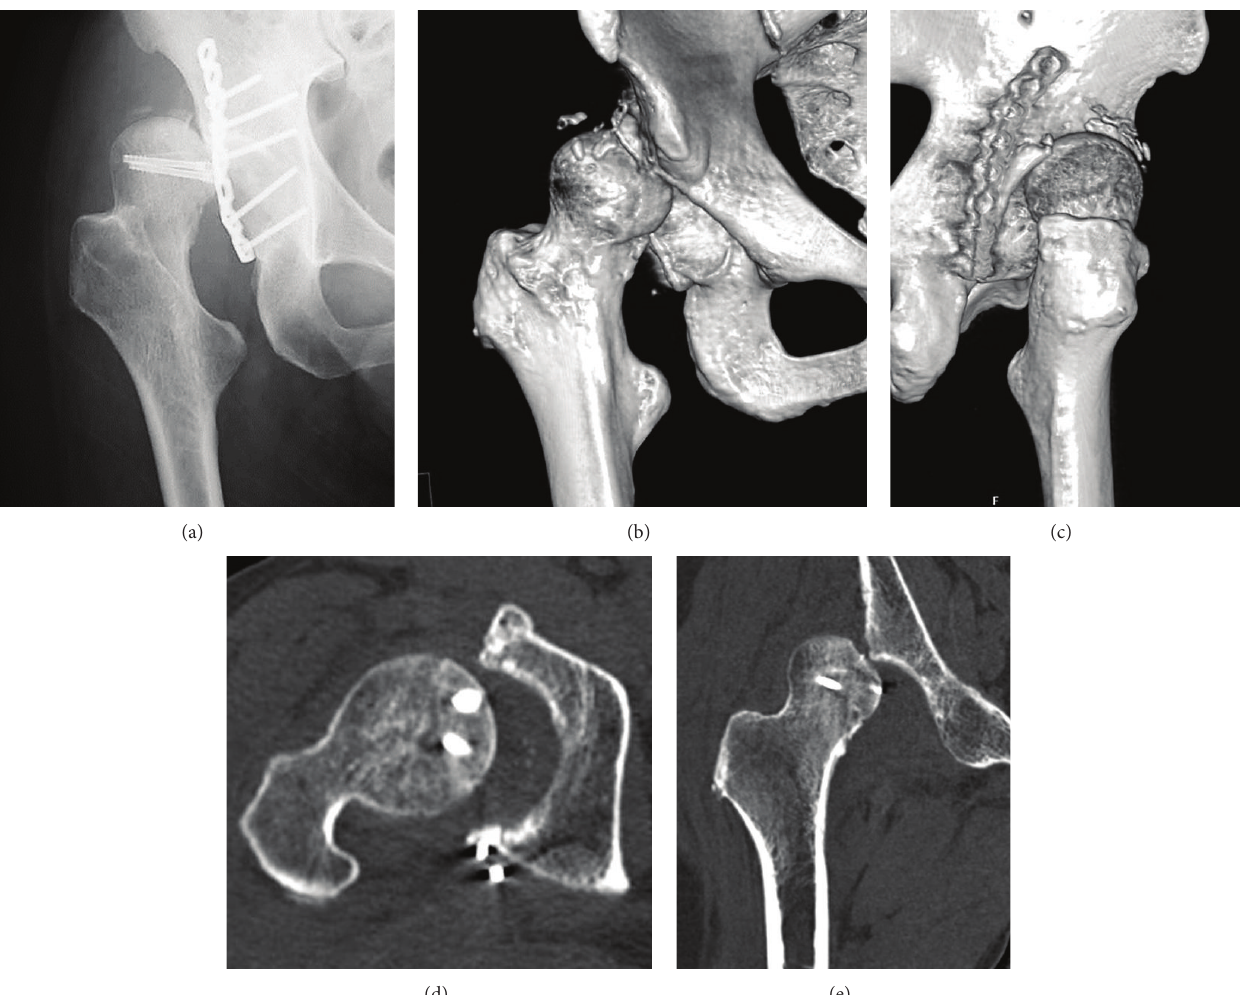
Figure 3: Case 1. (a) Anteroposterior X-ray image of the right hip at the superolateral dislocation. (b) Anteroposterior three-dimensional computed tomography showing superolateral dislocation of the femoral head and a bony defect of the superior part of the acetabular rim. (c) Posteroanterior three-dimensional computed tomography showing no displacement of the posterior fragments or implant failures. (d) Axial computed tomography showing irregular congruity, no displacement of the femoral head or posterior wall. (e) Coronal computed tomography showing superolateral dislocation of the femoral head and no displacement of the femoral